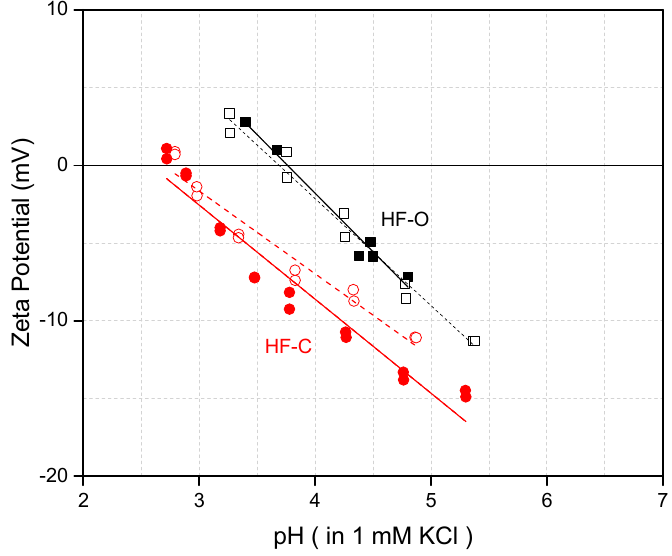
Figure 3. Zeta potential as a function of pH at the inner surface of the HF–C and HF–O membranes.